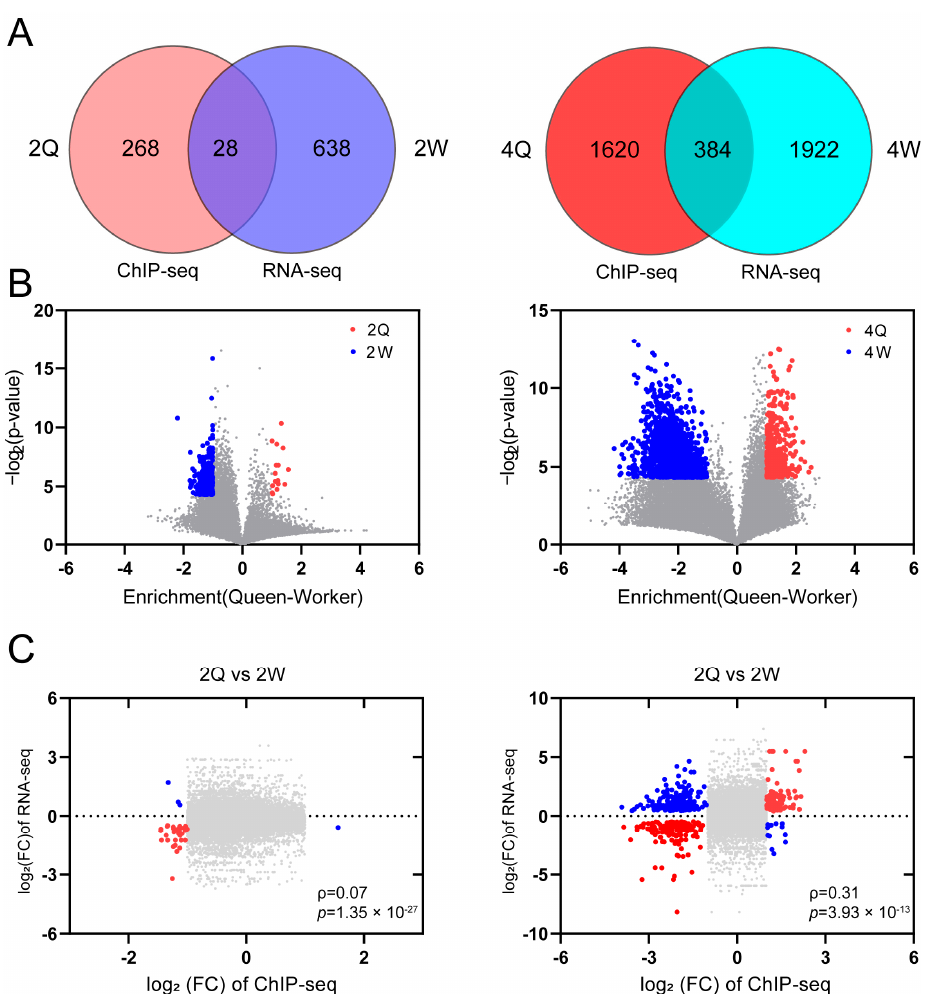
Figure 2. ( A ) Venn diagram showing overlap of differentially H3K4me1-modified genes and DEGs between queens and workers. ( B ) Volcano plot of the difference in enrichment between queens and workers against the negative log p -value for the H3K4me1 signal. Red areas indicate that the H3K4me1 modification is up-regulated in queens. Blue areas indicate that the H3K4me1 modification is up-regulated in workers. Gray indicates a lack of a significant difference ( p > 0.05). ( C ) Scatter plots of the significant differences in expression, determined by ChIP-seq, between queen and worker larvae ( x -axis) against the Log 2 FC of transcript expression between queen and worker larvae ( y -axis). Red indicates that the differences determined by RNA-seq and ChIP-seq are in agreement. Blue indicates that the opposite patterns were obtained by RNA-seq and ChIP-seq. Gray indicates that there is no significant difference ( p > 0.05).